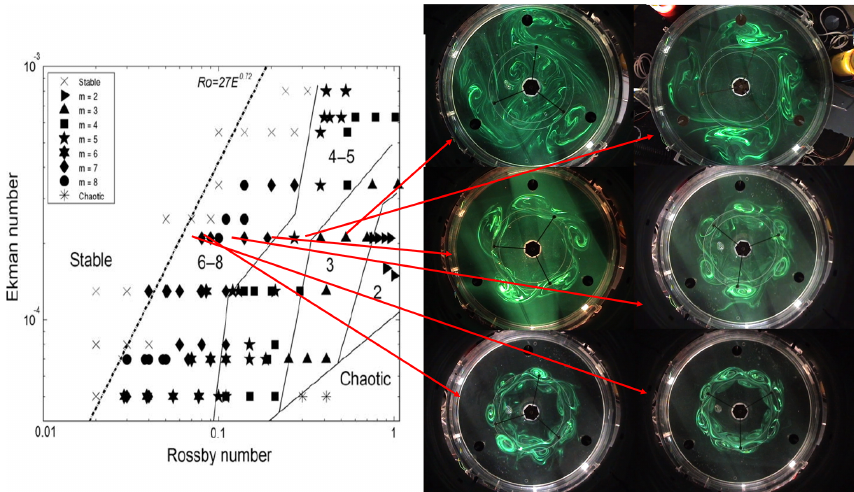
Figure 4. Regime diagram for the barotropic jet flows as a function of the Rossby and Ekman number, as obtained by Aguiar et al. (2010), showing snapshots of typical equilibrated flows as visualised using dye and side illumination. The trend towards a higher wavenumber, at the stability boundary as Re = Re c , is approached is clearly